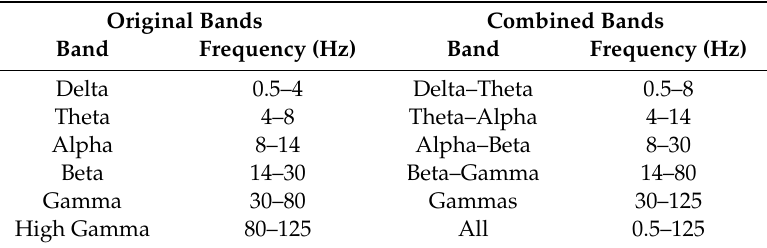
Figure 1. Algorithm flowchart. EEG = electroencephalography, FFT = fast Fourier transform, PBI = power in a band of interest. Table 1. Frequency band